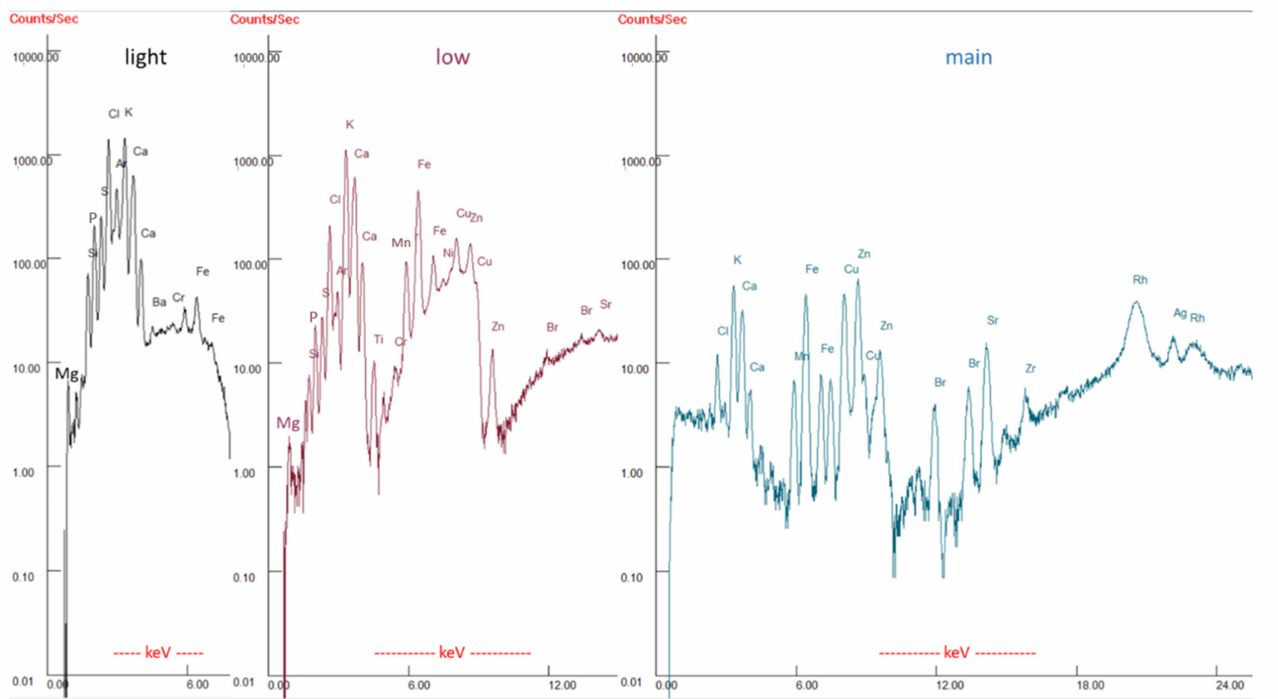
Figure 2. XRF fluorescence spectra of light, low, and main filter settings of a dried pig manure sample (log-scale for